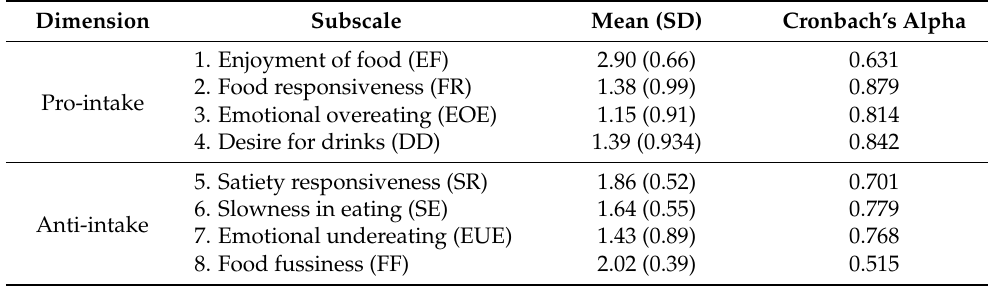
Table 1. Mean score and internal consistency of the CEBQ in the analyzed sample. (N = 283). Dimension Subscale Mean